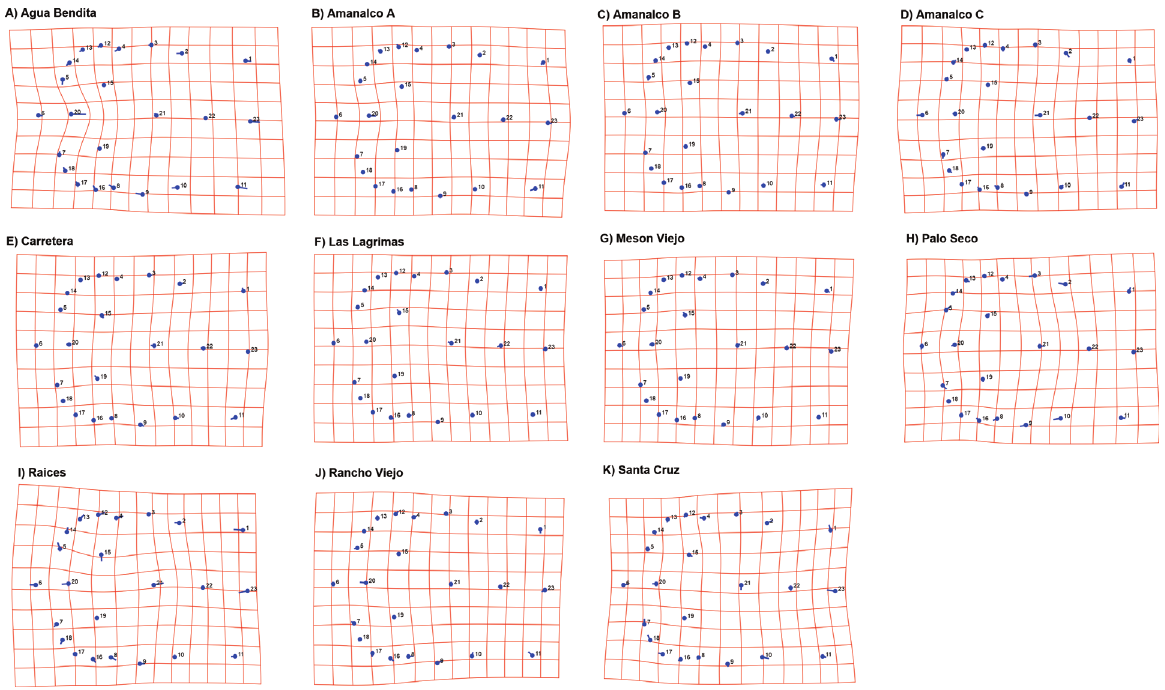
Figure 5. Deformation grids of the head landmarks of adult P. robertsi individuals.